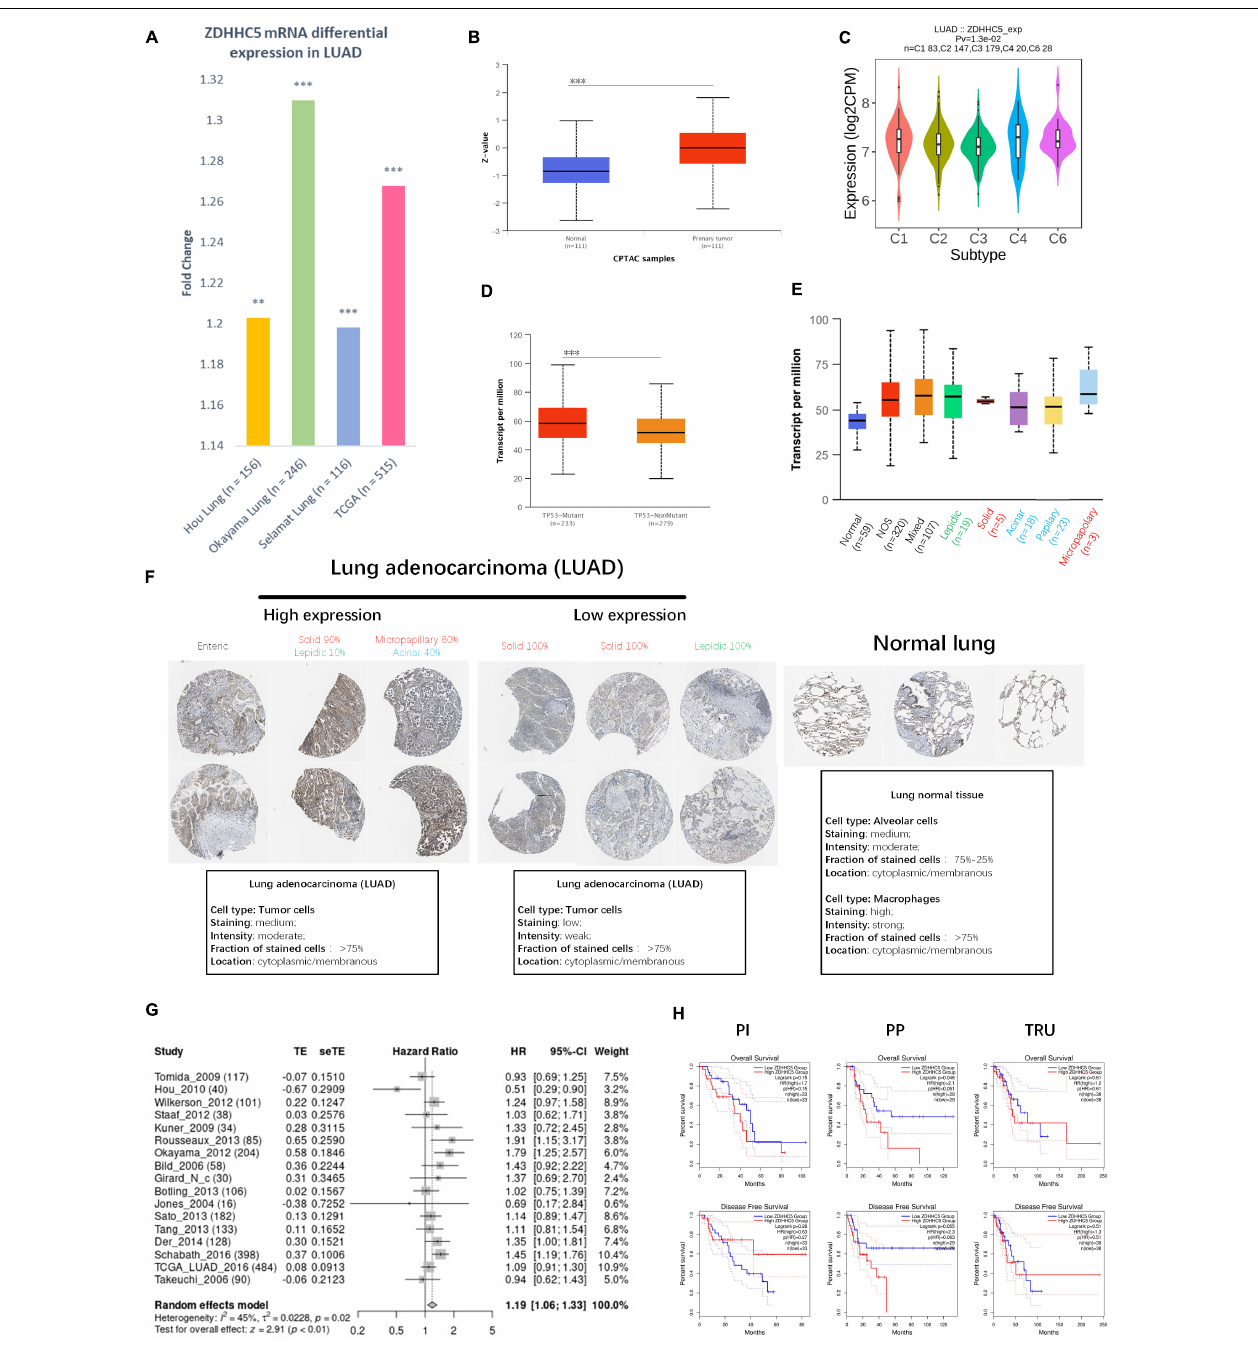
FIGURE 2 | Expression of ZDHHC5 in LUAD. (A) Fold change of ZDHHC5 differential expression in datasets of lung adenocarcinoma from the GEO and TCGA database. (B) Box plot indicates the differential protein expression of ZDHHC5 in the LUAD sample from CPTAC. Z -value, standard deviations from the median across LUAD samples. ** P < 0.01, *** P < 0.001. (C) Distribution of ZDHHC5 expression in LUAD across immune subtypes. (D) Box plot showing mRNA expression of ZDHHC5 in LUAD based on TP53 mutation status. (E) Box plot showing the relative transcription of ZDHHC5 in histological subtypes of LUAD patients. LUAD-not otherwise specified (NOS), LUAD mixed subtype (Mixed), lung solid pattern predominant adenocarcinoma (Solid), lung acinar adenocarcinoma (Acinar), lung micropapillary adenocarcinoma (Micropapillary), lung papillary adenocarcinoma (Papillary). (F) Representative immunohistochemistry results of ZDHHC5 in LUAD. We evaluated histological subtypes to address the heterogeneity of ZDHHC5 in growth patterns of LUAD and normal lung tissues. The histological subtype was classified by a clinical pathologist, and semiquantitative estimations of the different histological patterns present in 5% increments according to the 2015 WHO Classification of Lung Tumors. Enteric adenocarcinoma (Enteric); lepidic adenocarcinoma (Lepidic). (G) Forest plot showing adjusted analysis of ZDHHC5 survival probability on OS in LUAD patients from 17 independent studies. The summarized HR is 1.19, P < 0.05. CI, confidence interval. (H) Kaplan-Meier survival curves of OS and DFS were generated for the comparison of ZDHHC5’s prognostic value in the 3 molecular subtypes of LUAD. The threshold of significance is P < 0.05 in Log-rank test. PP, Proximal-proliferative; PI, proximal-inflammatory; TRU, Terminal respiratory unit.